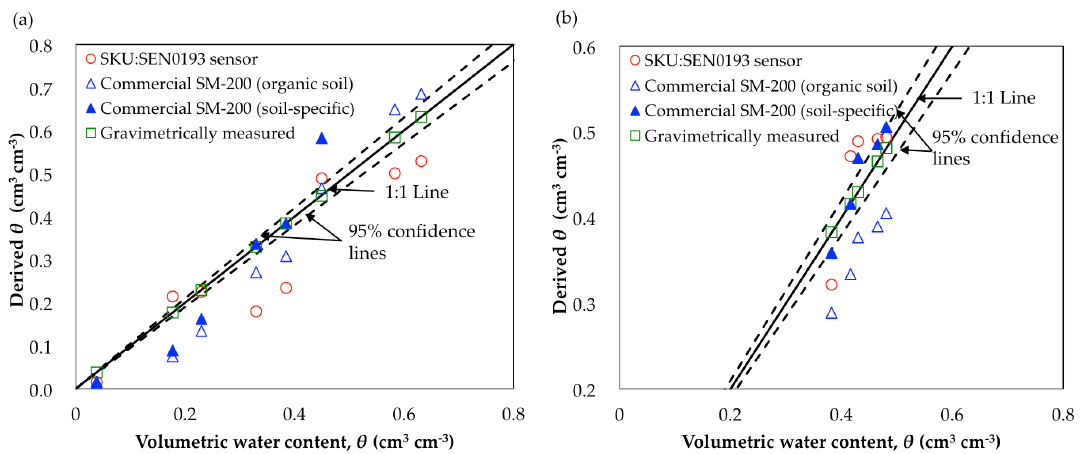
Figure 4. The samples’ soil water contents θ derived from the polynomial function of the SKU:SEN0193 sensor, the polynomial function of the SM-200 sensor for organic soil (manufacturer’s function), and the soil-specific calibration function as a function of volumetric water content: ( a ) in the range of soil water contents from dry to saturated, ( b ) in the range of the field capacity.